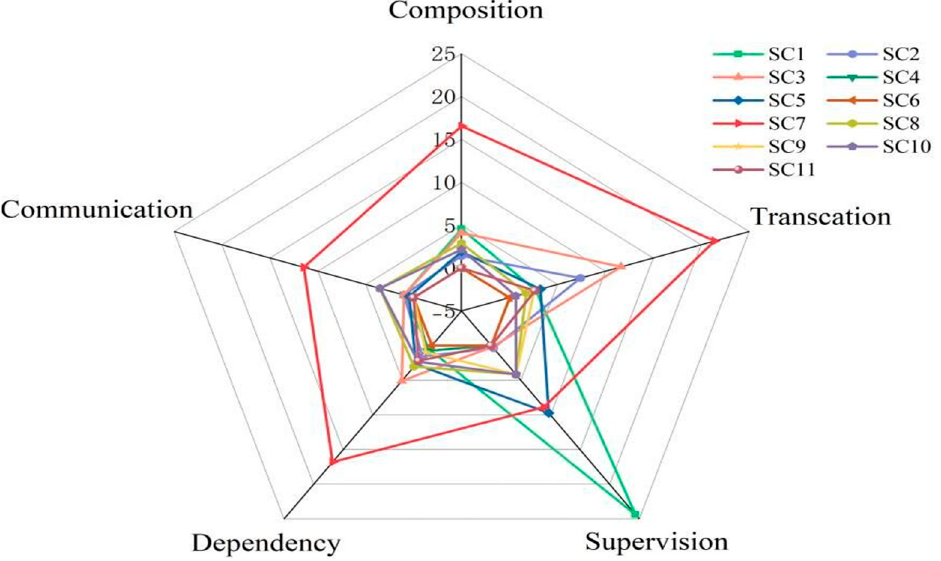
Figure 5. Betweenness centrality comparison of relationship networks.